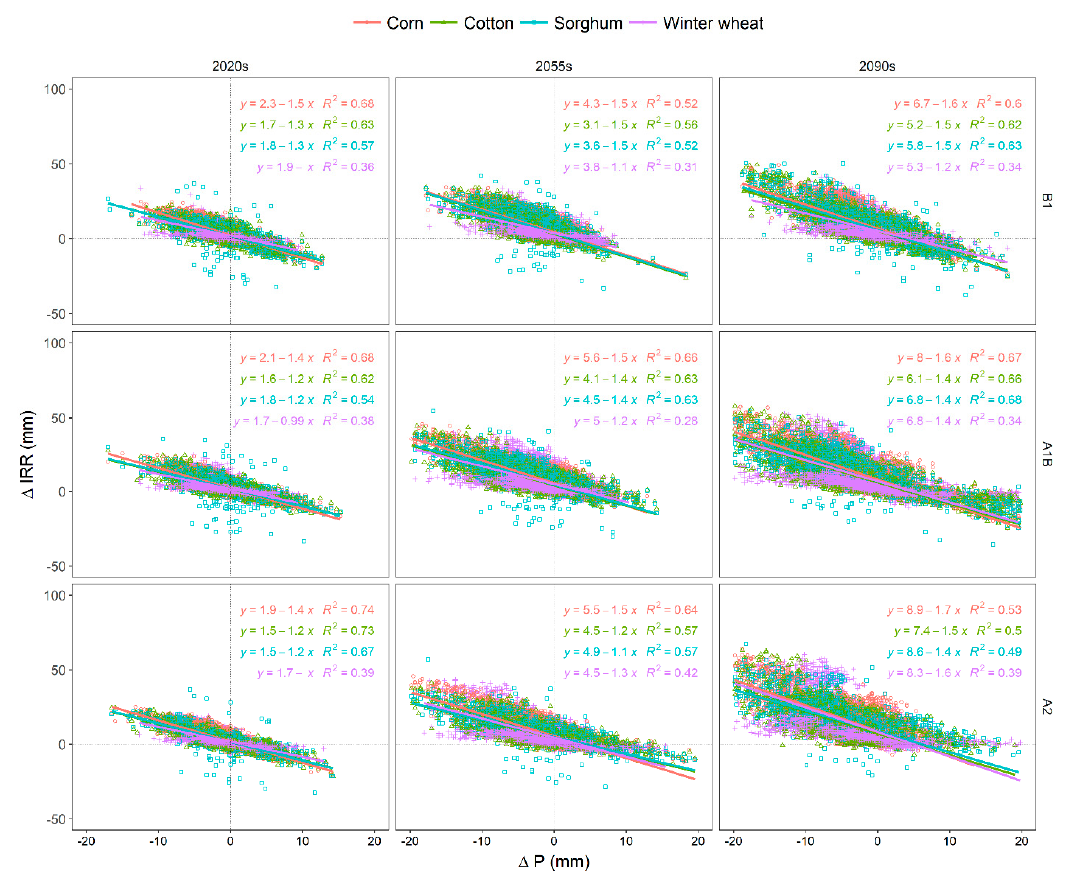
Figure 7. Effects of changes in precipitation on crop irrigation requirements of corn, cotton, sorghum, and winter wheat in the Brazos Headwaters Basin.